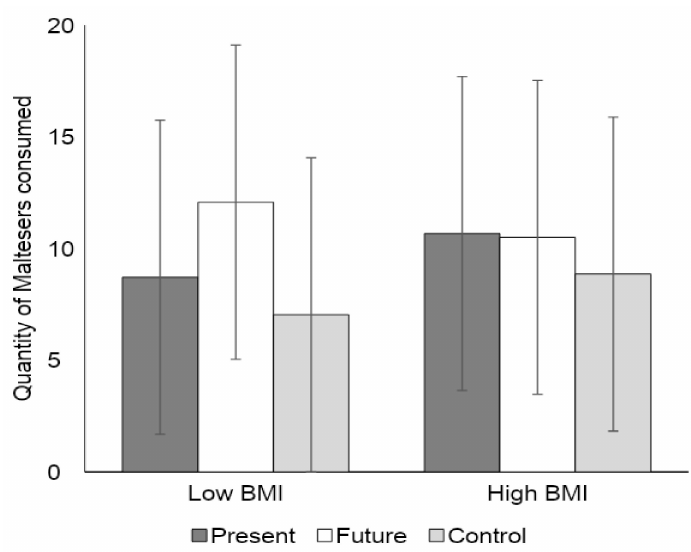
Figure 1. Quantity of Maltesers consumed at low (1 SD below the mean) and high (1 SD above the mean) levels of BMI for each condition in Experiment 1. The error bars represent the prediction